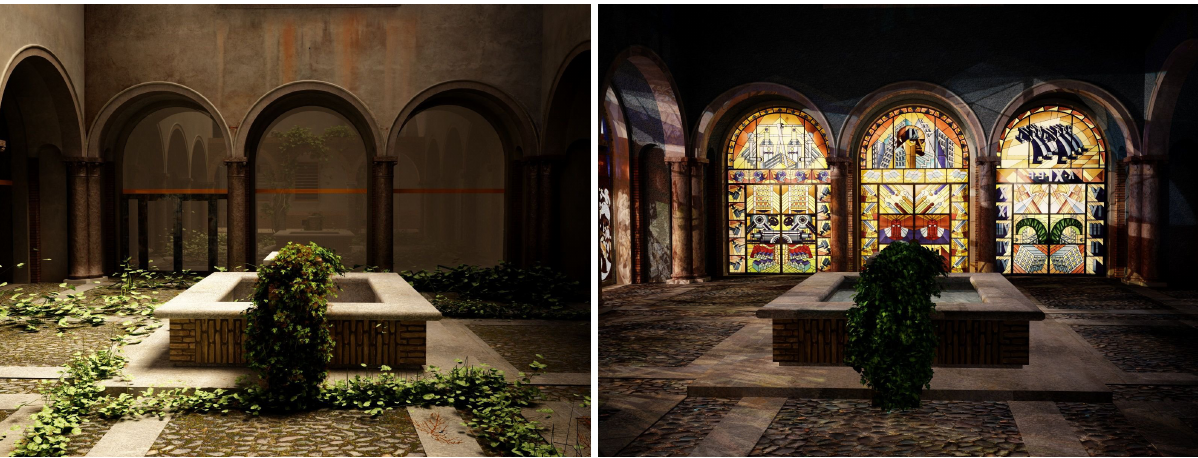
Figure 9. The Post office, Trento: on the left virtual view of the current inner courtyard, on the right ideal reconstruction of the full- length windows designed by Fortunato Depero (authors: Fabrizio Broch, Irene